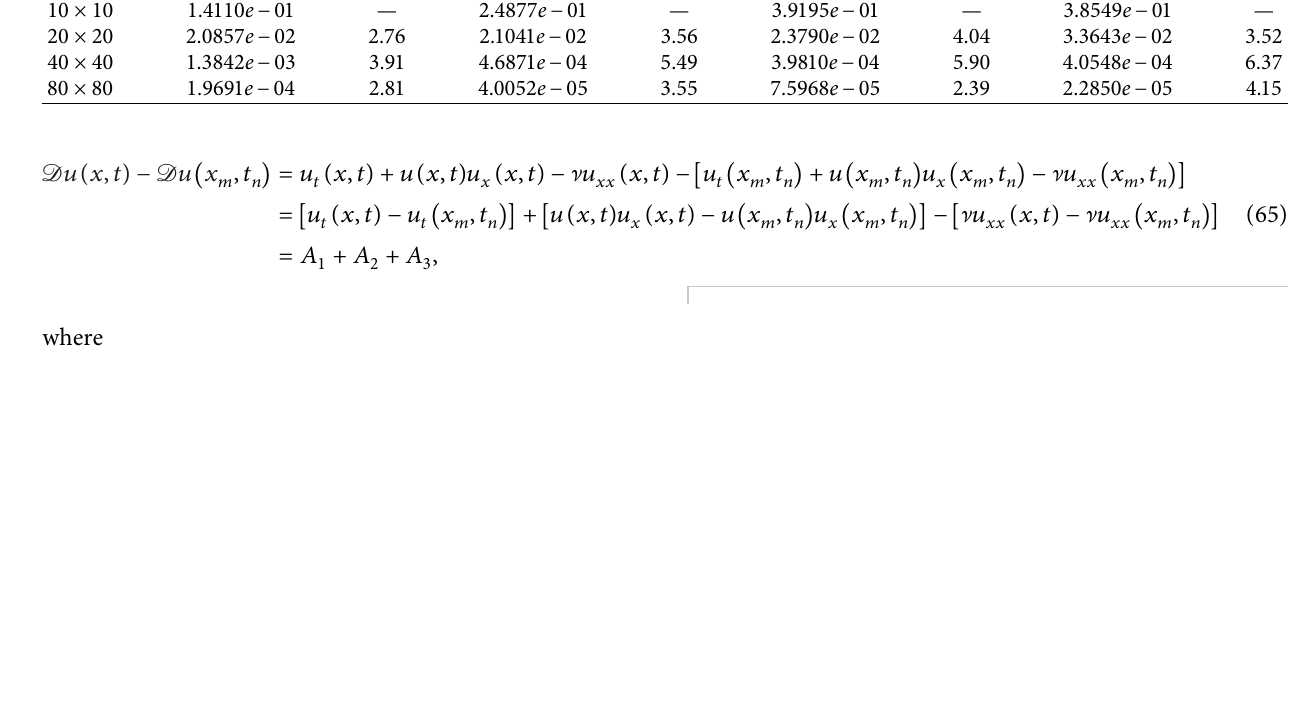
Table 7: Errors and convergence rates in the case of Chebyshev nodes with time interpolation parameter d m × n d � 1